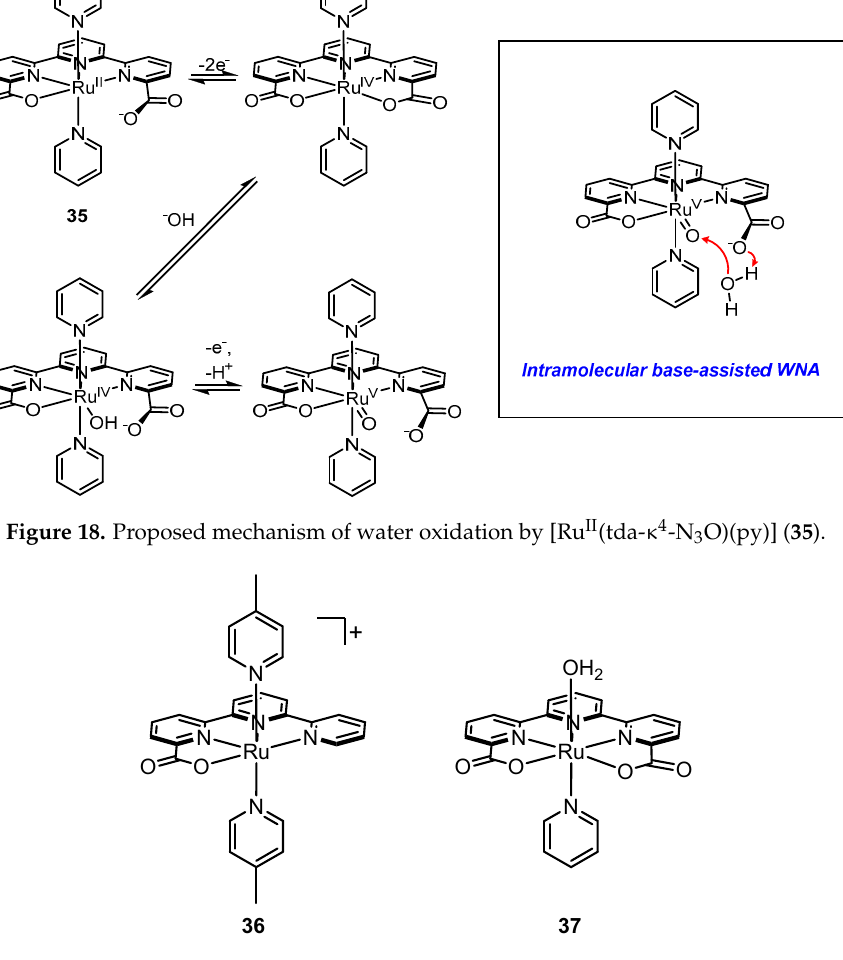
Figure 19. Variations of catalyst 35 that are significantly less catalytically active.